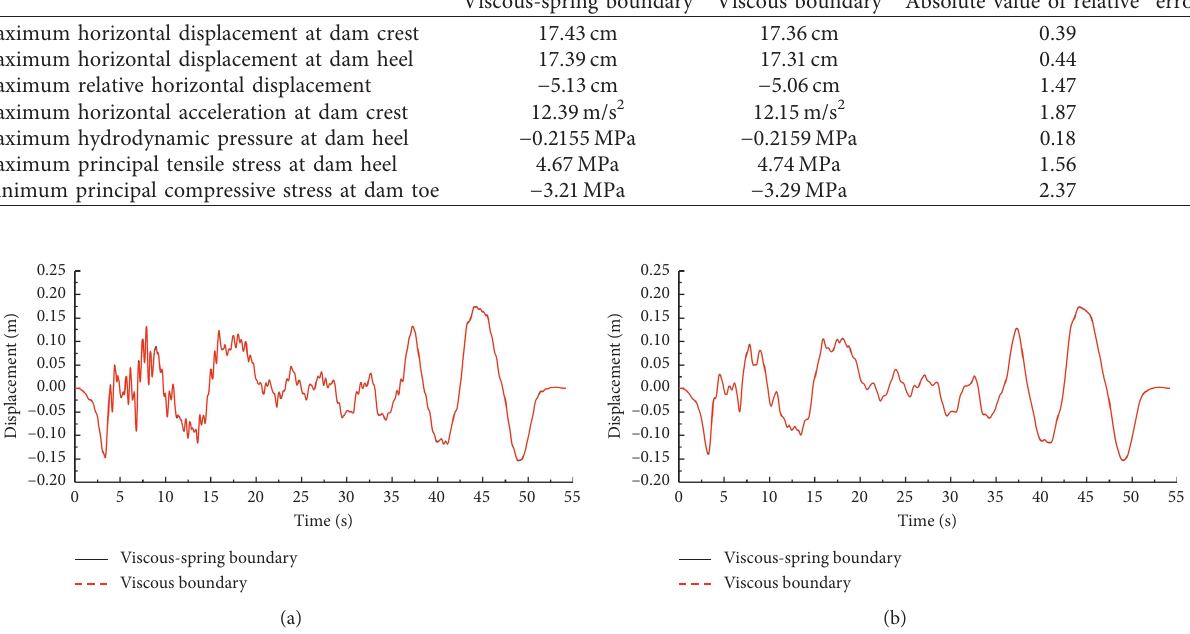
Figure 8: Time histories of horizontal displacements of the Pine Flat dam. (a) Dam crest. (b) Dam heel.